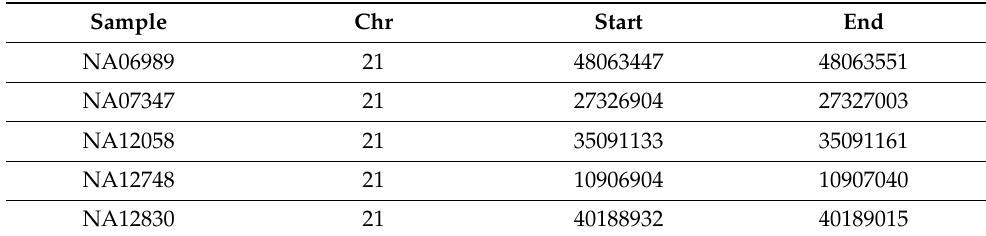
Table 6. The 5 simulated HDs inserted in samples of 1KGP